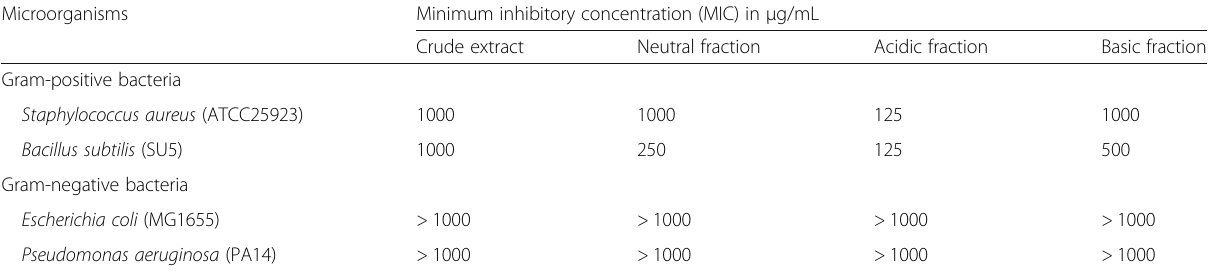
Table 2 Antibacterial activities of crude ethanolic extract of S. asper leaves and its fractions against a range of microorganisms determined by the broth microdilution method